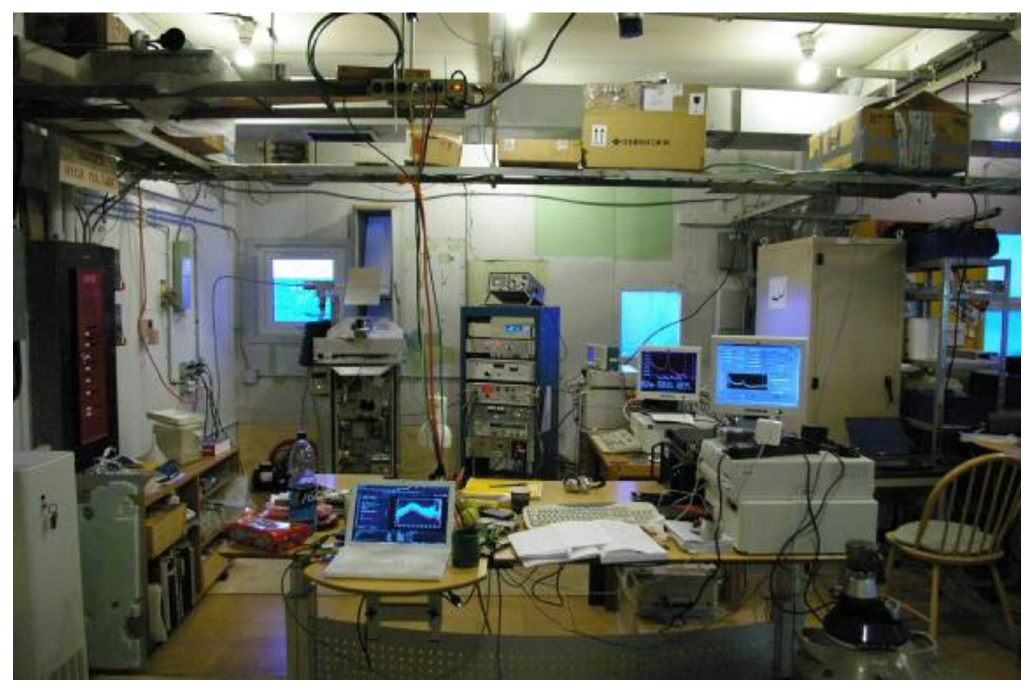
Figure 3. The GBMS installed at Thule, with the receiver facing the mm-wave window.